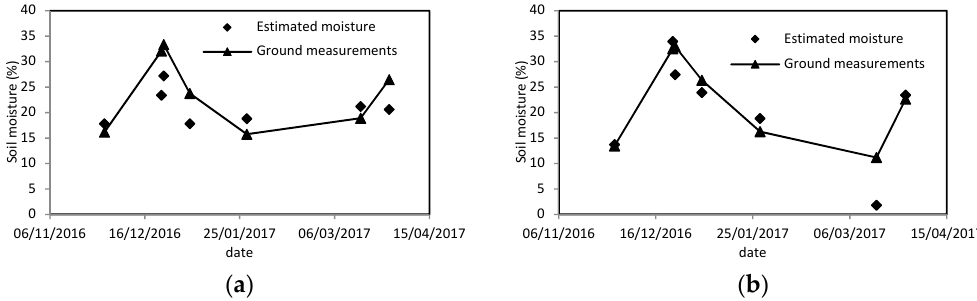
Figure 5. Temporal variations of the remotely sensed and measured soil moisture, for two reference fields: ( a ) Field P19; ( b ) Field P21.